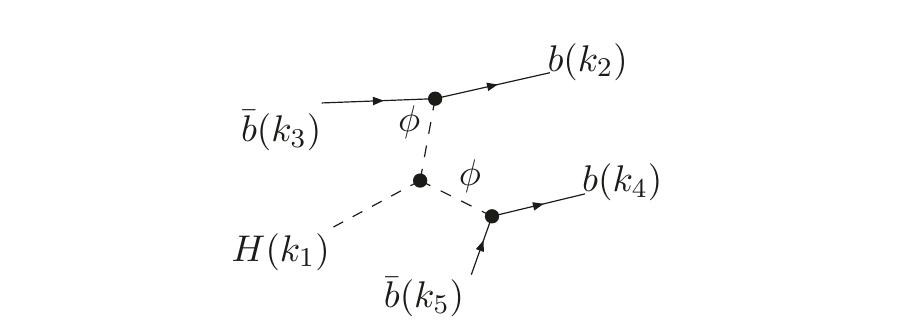
Figure 18 . Similar to figure 7 for distribution as a function of the energy asymmetry of all b -jet pairs.